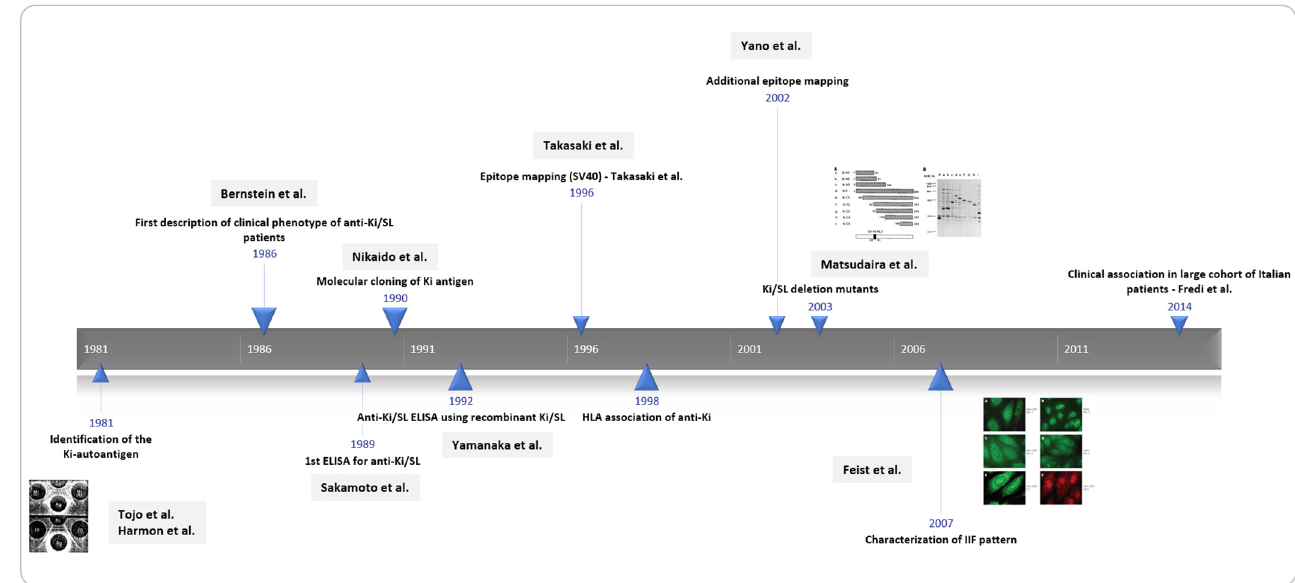
Figure 1. Four historical decades of anti-Ki/SL antibodies. The history of anti-Ki/SL antibodies started with the discovery by Tojo and Harmon et al. in 1981, followed by several clinical association and epitope mapping studies. ELISA=enzyme linked immunoassay; HLA= Human Leukocyte Antigen; SL=sicca lupus